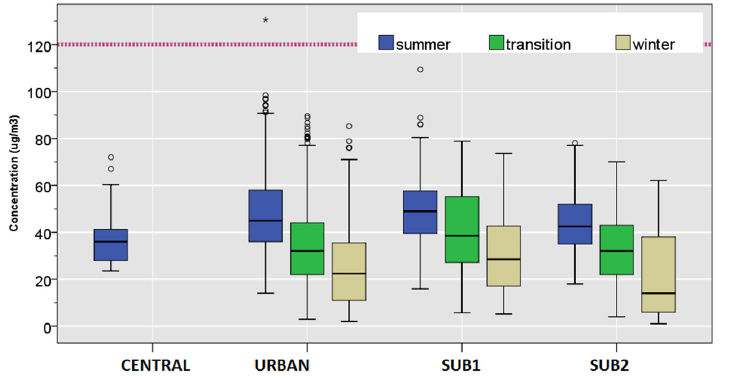
Figure 8. Distributions of daily mean tropospheric ozone concentration by season. The dotted line on (a) shows the EU standard of 120 µg/m 3 for maximum daily 8-hour